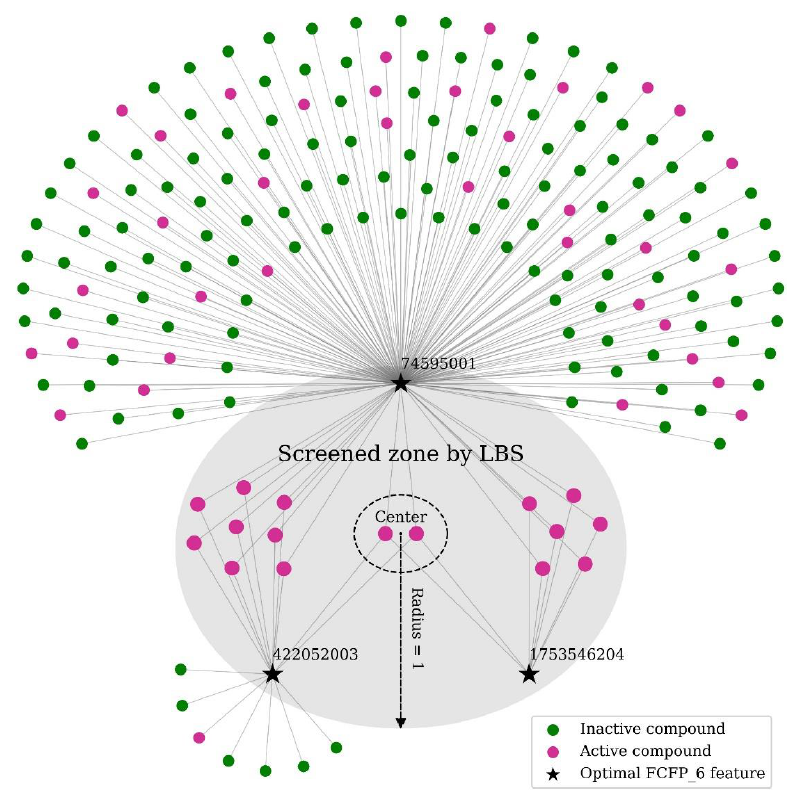
Figure 5. Interpretation of the model trained by LBS. A node represents a compound or a feature, and an edge means that the feature exists in the structure of the corresponding compound. In the optimal screened zone (gray-filled part) trained by LBS, the center (black dashed circle) connected to all the three optimal FCFP_6 features and the radius was one. It can be interpreted as a screening rule that a candidate is regarded as an active compound if its structure contains at least two of the three optimal features. FCFP: functional-class fingerprints.